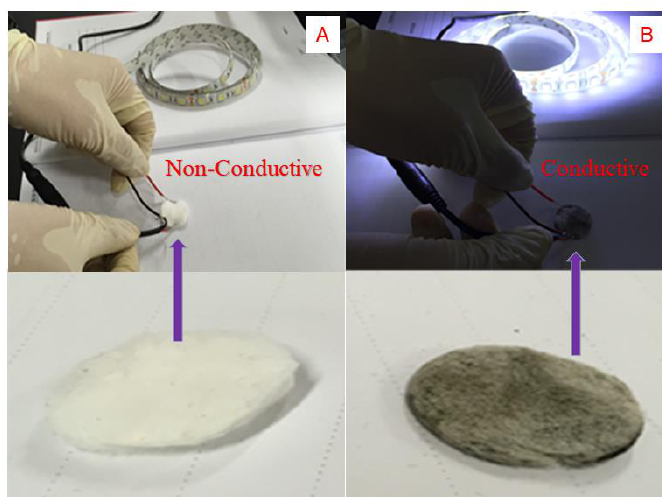
Figure 7. Conductivity test for ( A ) the pristine cotton and ( B ) Cotton-Ag.